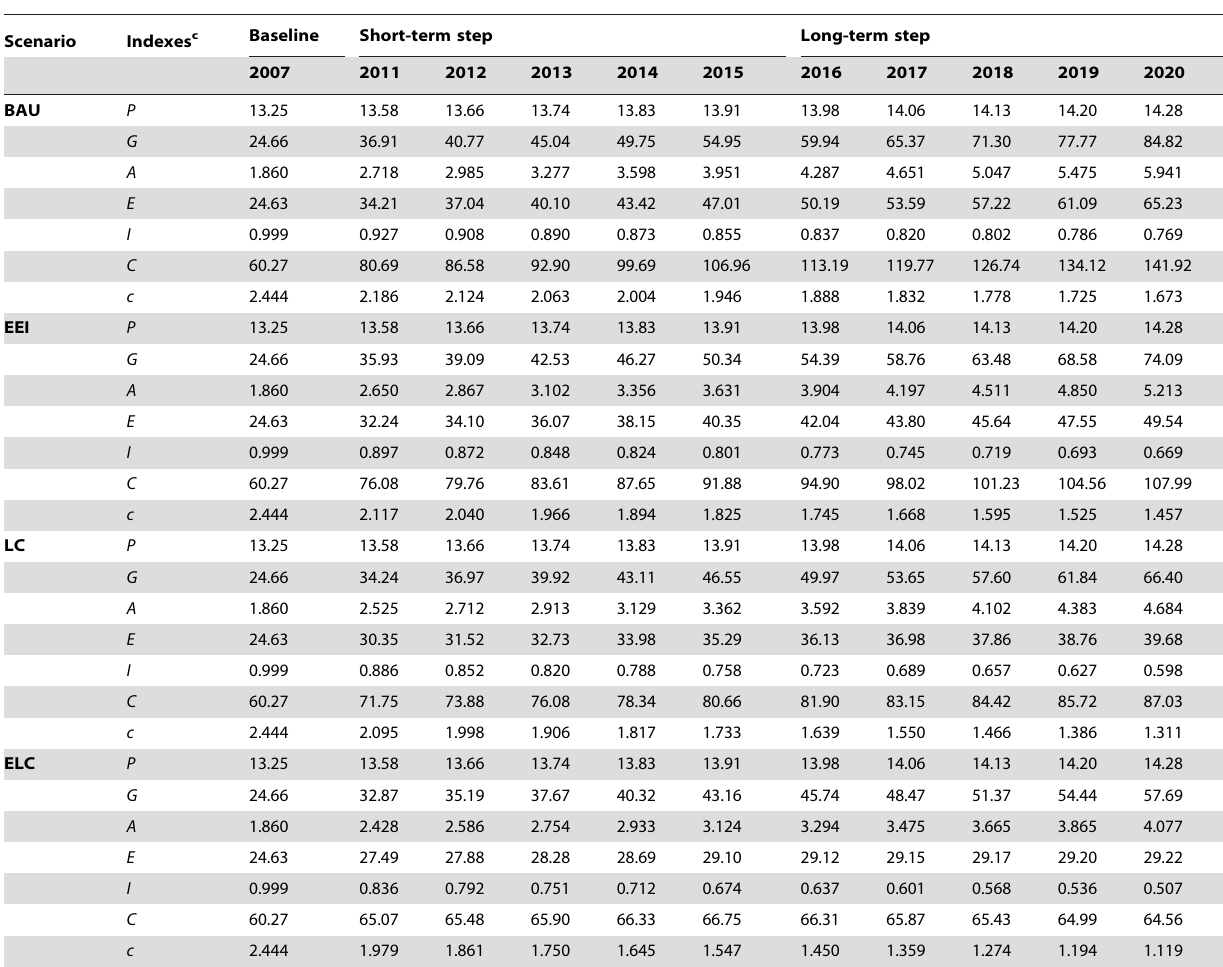
Table 3. Prediction result of scenario indicators (2007–2020).